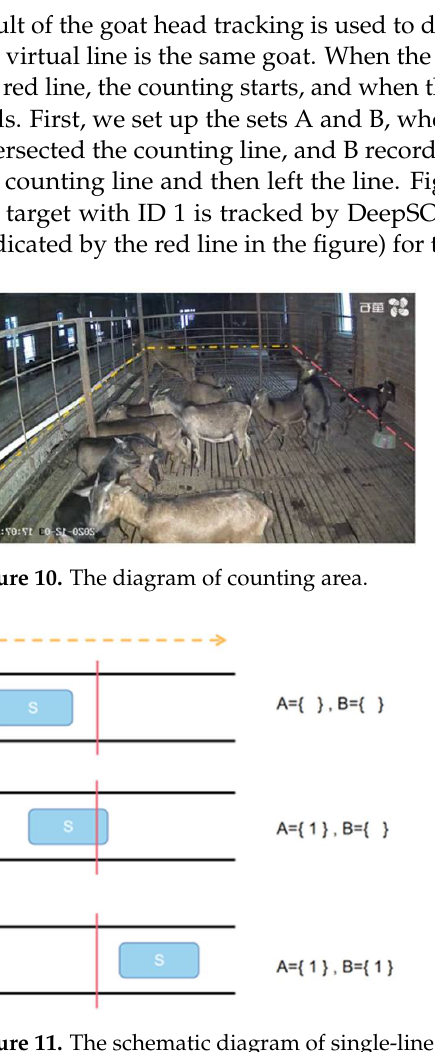
Figure 11. The schematic diagram of single-line counting method.